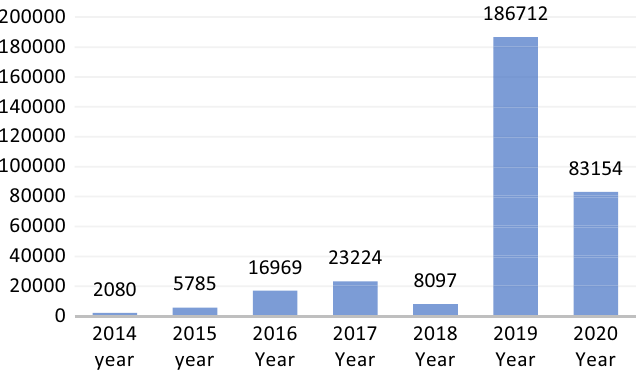
Fig. 6 Distribution of RCEP tweets per